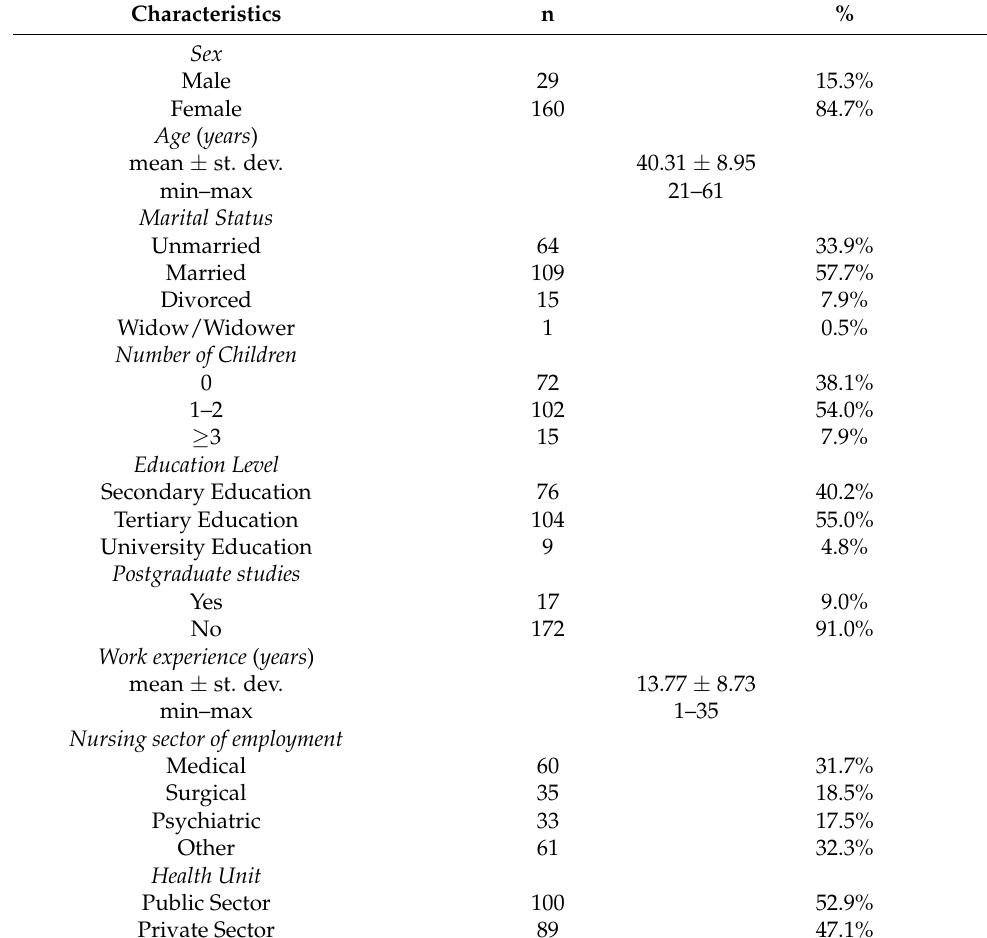
Table 1. Personal characteristics of the Nurses ( n = 189).